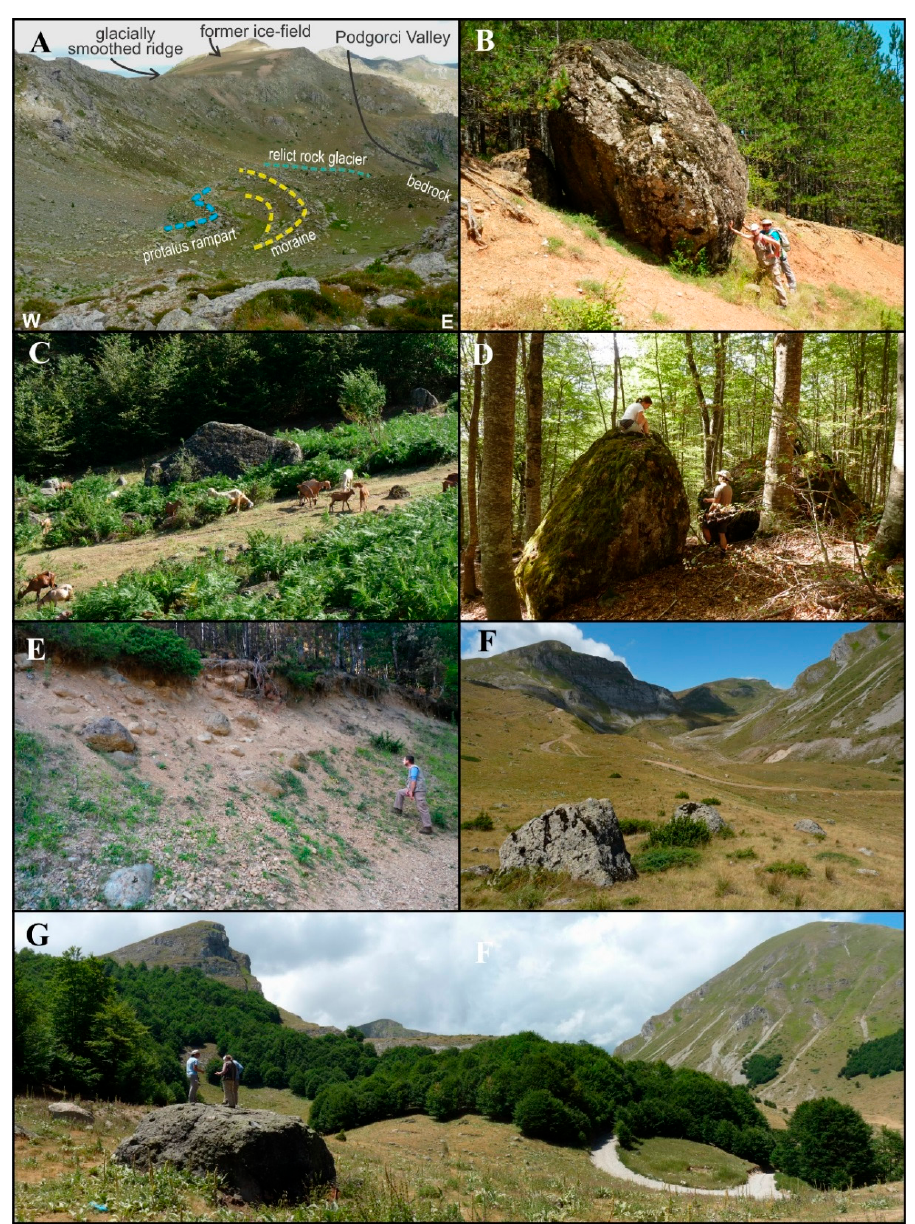
Figure 4. Glacial morphology and deposits on Jablanica Mountain. ( A ) The uppermost part of Podgorci Valley having ridges with glacially smoothed morphology; Large glacially transported boulders of Jurassic conglomerate (Vev č ani Member) in the lower parts of Vev č ani ( B ) and Podgorci ( C ) valleys; ( D ) Large boulders of Jurassic conglomerate in the middle part of Vev č ani Valley (Kutel Member); ( E ) Fluvioglacial deposits in the lower parts of Podgorci Valley; ( F ) Erratic boulder of Jurassic conglomerate (1.5 m high) laying on carbonate bedrock at Branica locality, with view of Pupuljak Valley in the back; ( G ) Large Jurassic conglomerate boulders of Leništa Member in Labuništa-Pupuljak Valley at Leništa locality. For location of the photos refer to Figure 3. The main ridge reaches an elevation between 2000 and 2200 m, and likely preserves a remnant of a Paleogene planation surface, which can be found on other mountains in Macedonia [29]. Several sections of the main ridge are smoothed, as well as multiple segments of the secondary ridges separating the cirques (Figure 4A). This morphology may reflect the former existence of a major